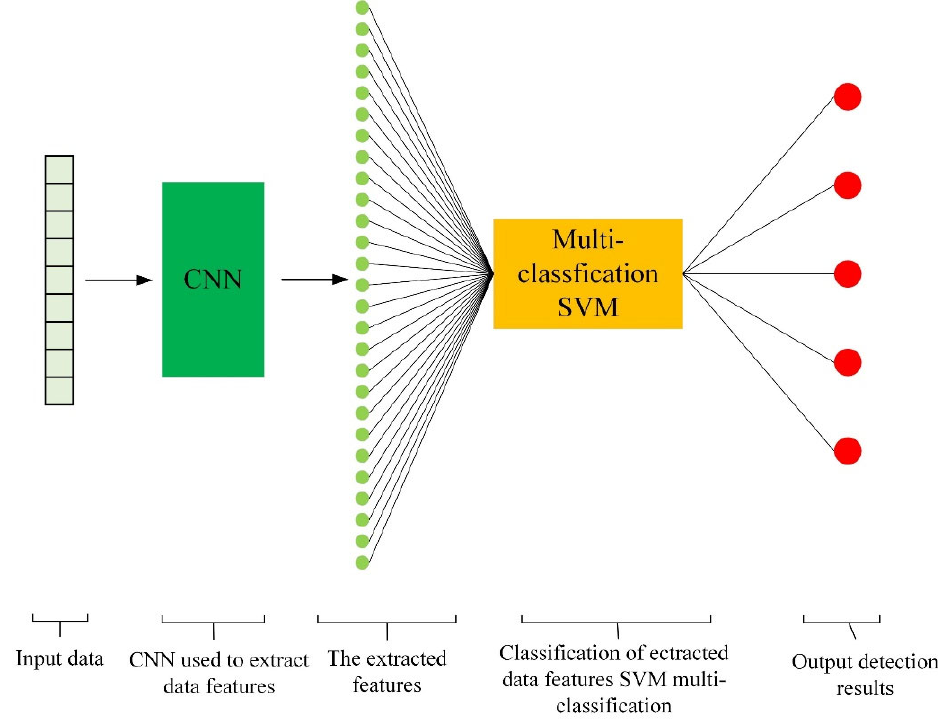
Figure 4. CNN ‐ SVM Model for Detection of Abnormal Data in IoT in Tea Plantations. Figure 4. CNN-SVM Model for Detection of Abnormal Data in IoT in Tea